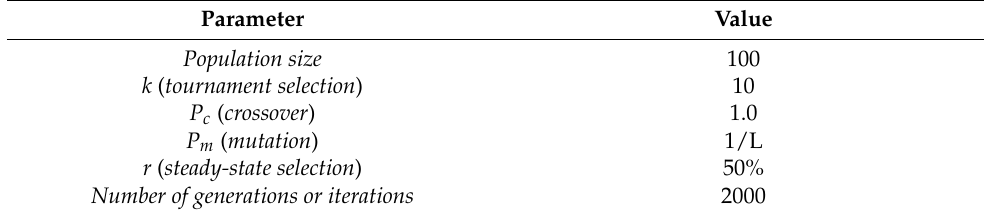
Table 2. Parameter settings of the evolutionary